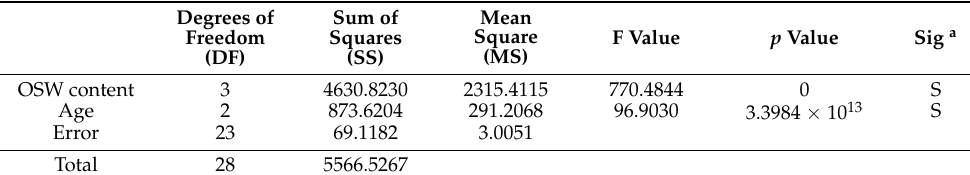
Table 3. Two-way ANOVA of compressive strength